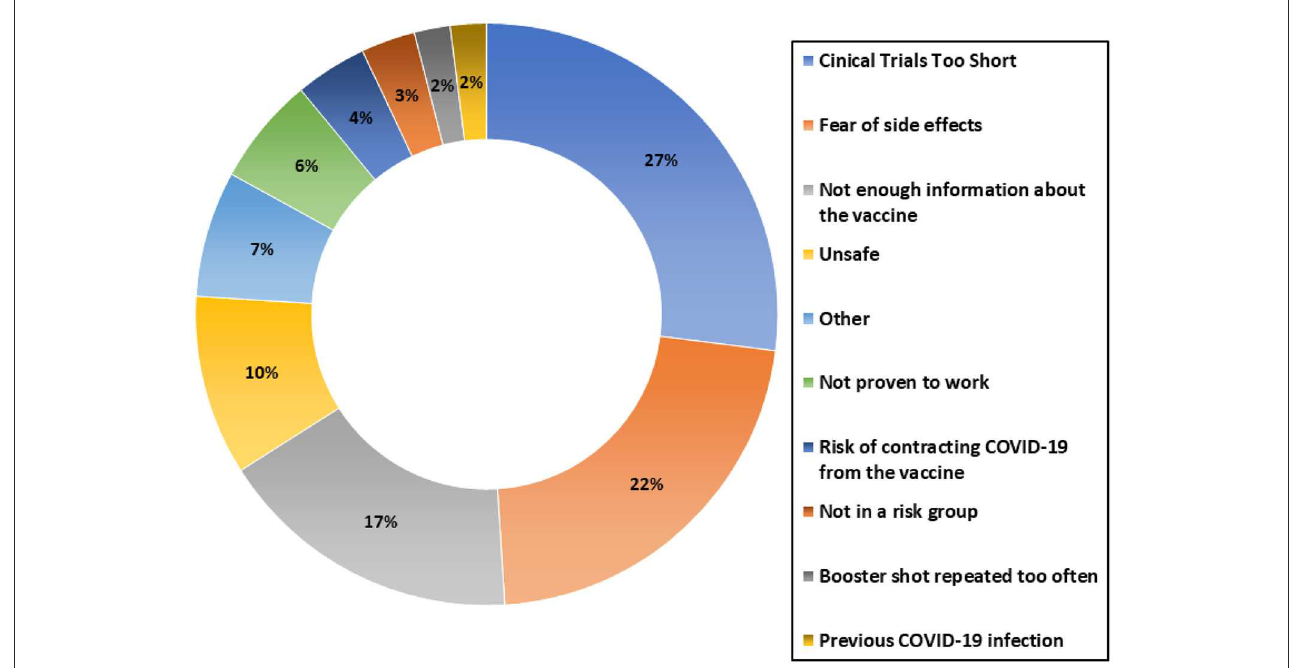
FIGURE5 Reasons for not being